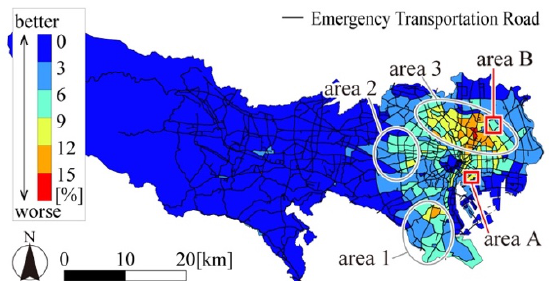
Figure 8. Spatial distribution of street blockage risk (emergency responder cannot pass, passible width: 0m)